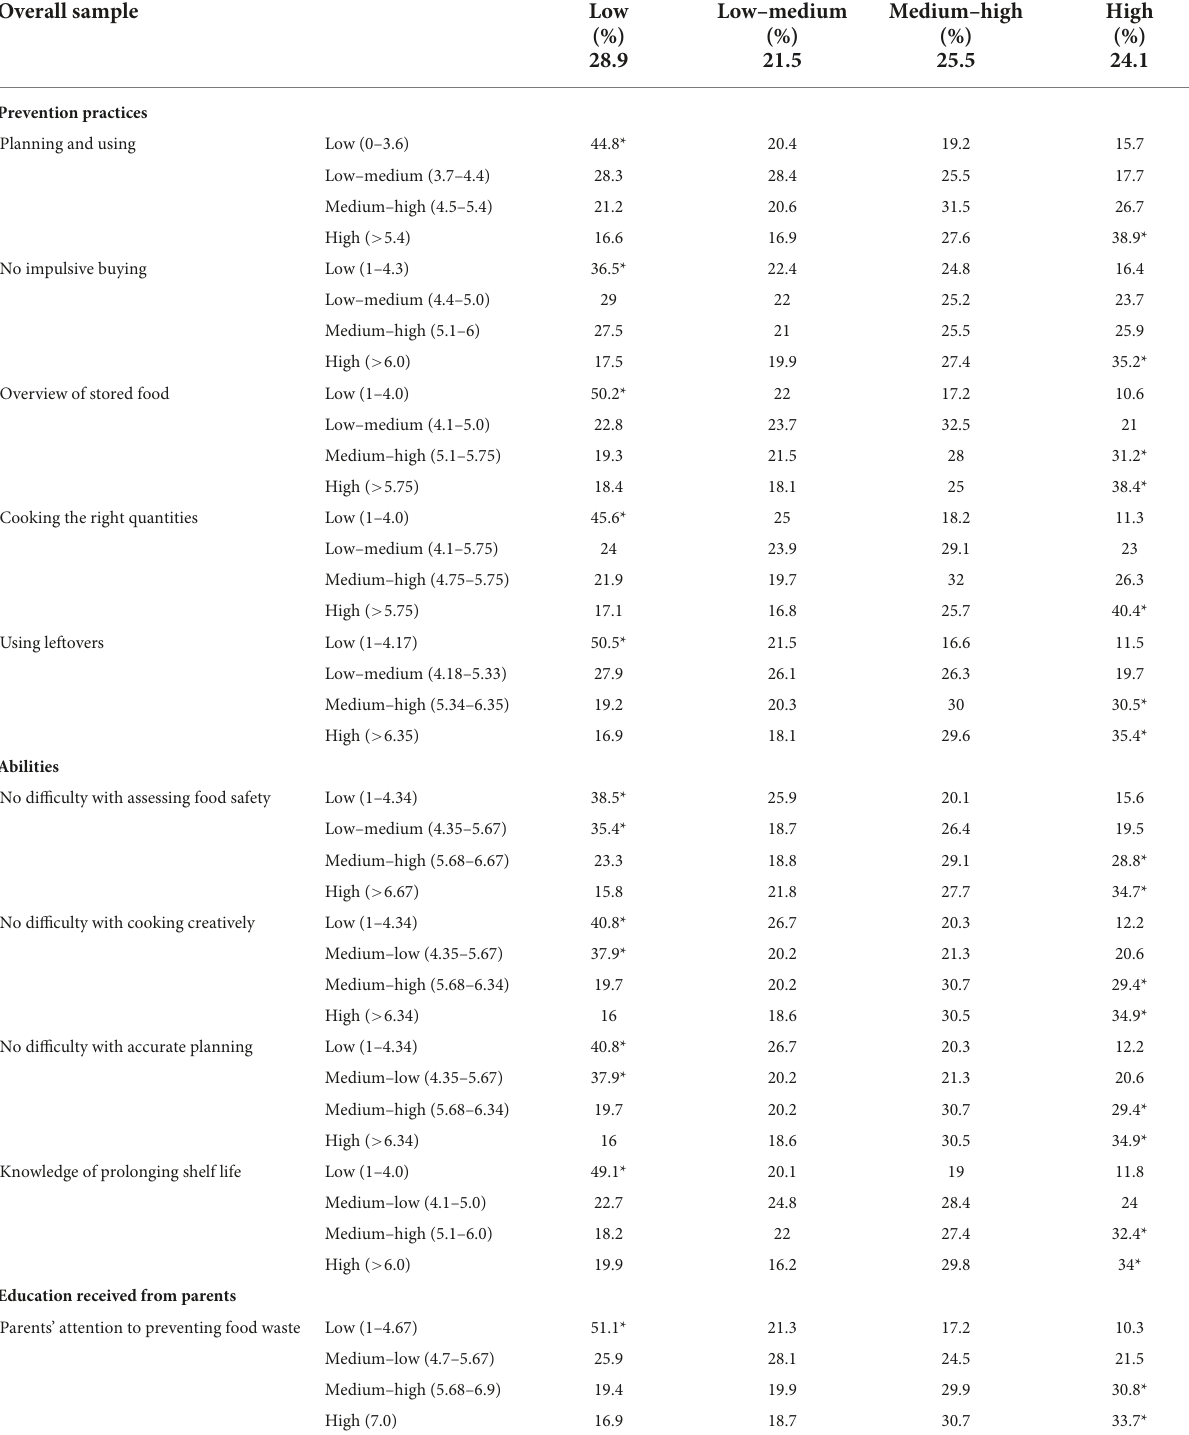
TABLE 1 The relationship between adherence to the Italian dietary guidelines indicator (AIDGI) and household food waste behaviors (HFWBs) (prevention practices, abilities, education received from parents). Overall